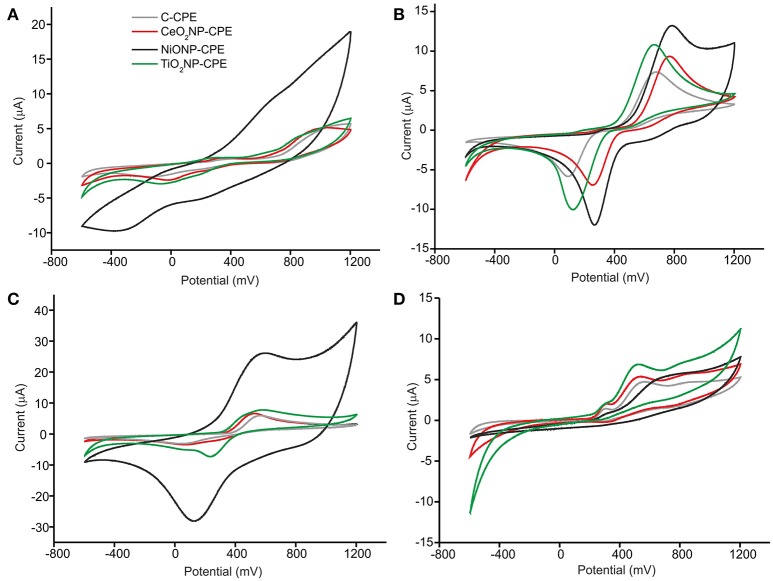
CV of (A) vanillic acid, (B) catechol, (C) caffeic acid, and (D) pyrogaloll at C-CPE, CeO2NP-CPE, NiONP-CPE, and TiO2NP-CPE electrodes. Concentration of 10−4M. Scan rate 100 mV·s−1.